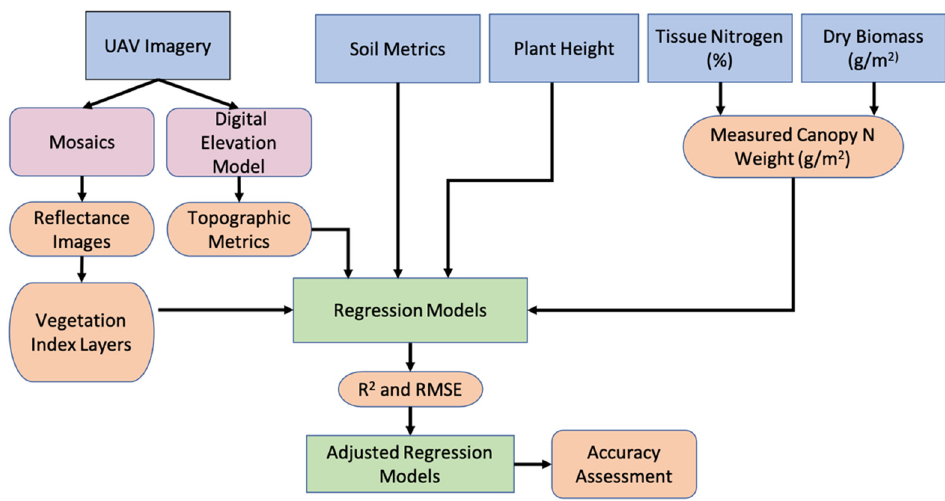
Figure 4. Flowchart of the methodology used in the study.